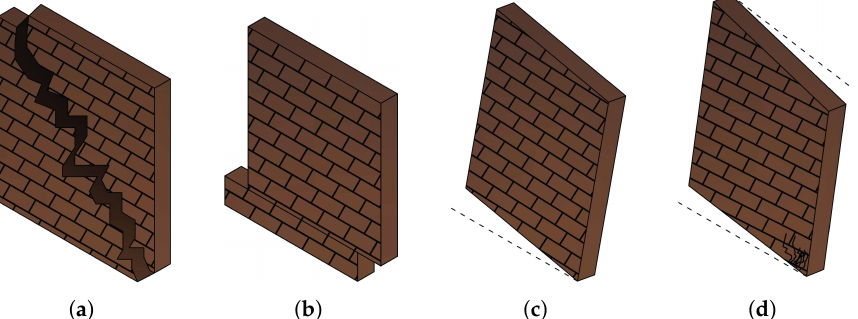
Figure 16. In-plane failure modes of URM walls; ( a ) shear failure; ( b ) sliding failure; ( c ) rocking failure; ( d ) toe